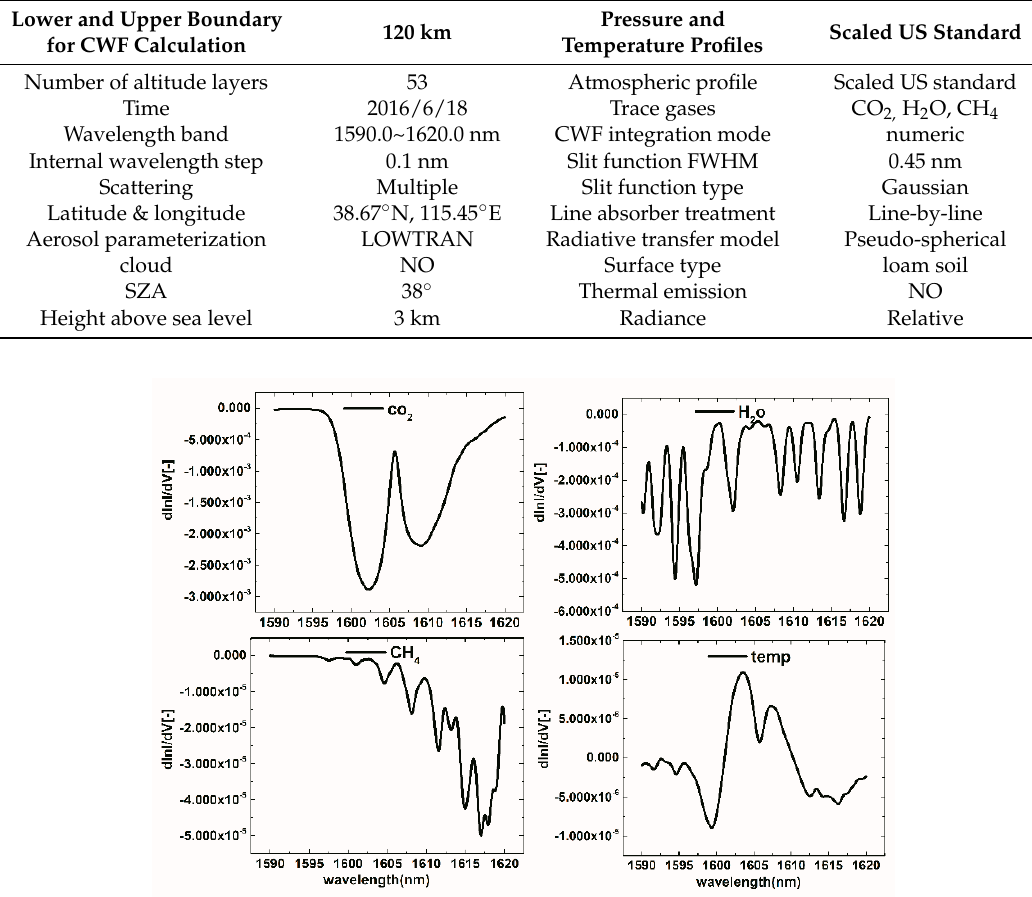
Table 1. The input parameters for SCIATRAN.